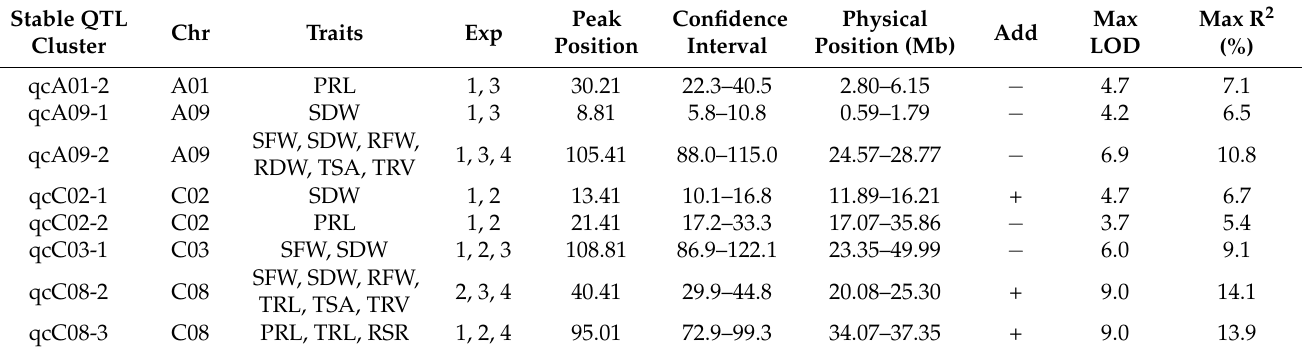
Table 2. Summary of stable QTL clusters detected for root-related and shoot biomass traits in the RIL population across four independent